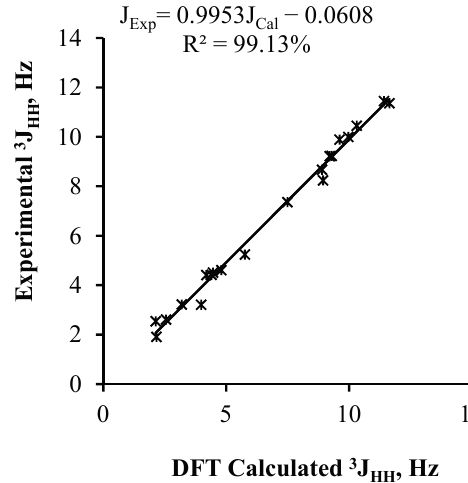
Figure 4. Correlation curves between experimental and PCM predicted 3 J constants of 2a and 2b